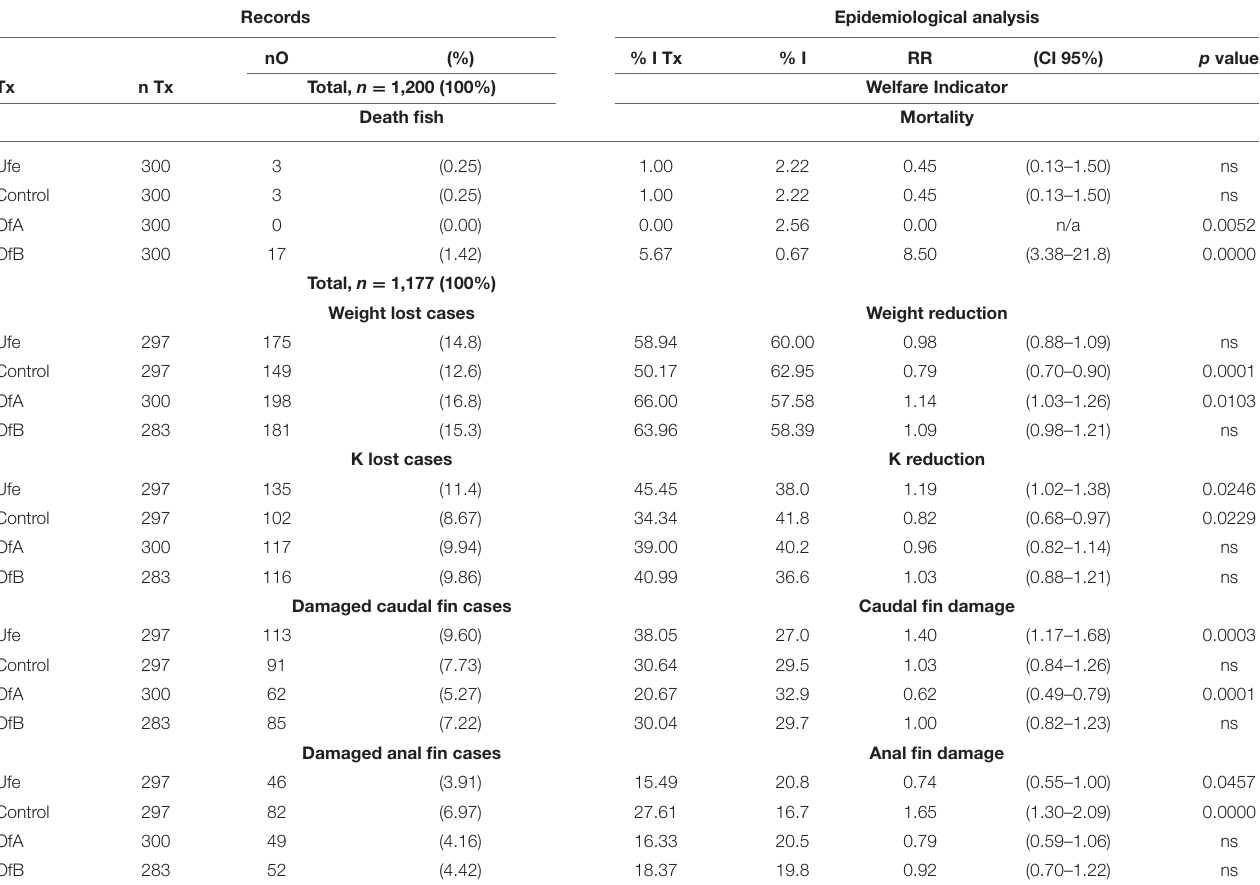
TABLE 7 | Contingency table, incidence of mortality, weight reduction, K reduction, and caudal and anal fin damage of on-growing 2 of O. niloticus according to the feeding